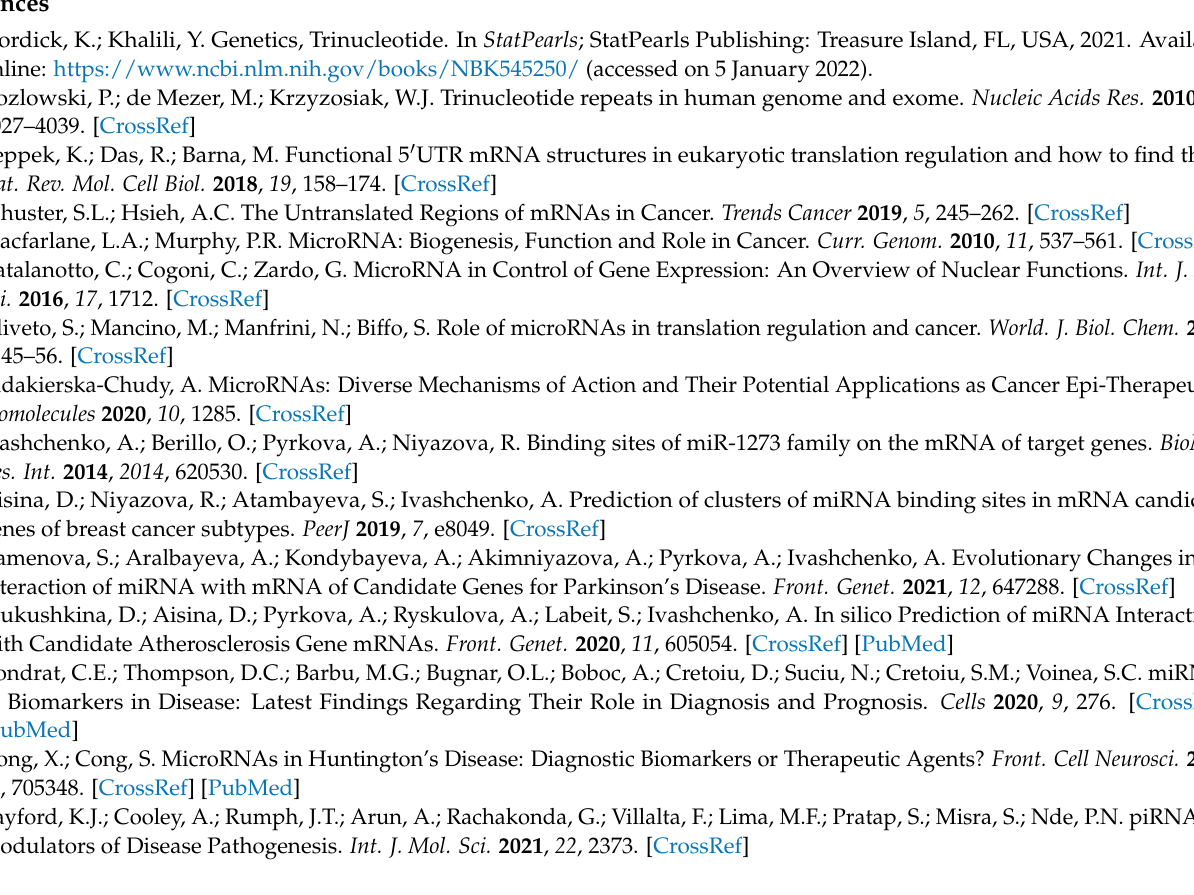
Table S2: Characteristics of miRNAs binding with the 3 (cid:48) UTR mRNAs of genes having GU and AC dinucleotide repeats and associated with oncological diseases. Table S3: Characteristics of miRNAs binding with the 3 (cid:48) UTR mRNAs of genes having GU and AC dinucleotide repeats and associated with diabetes diseases. Table S4: Characteristics of piRNA and miRNA interactions with the 5 (cid:48) UTR mRNAs of genes having trinucleotide repeats and associated with diseases. Table S5: Characteristics of piRNA and miRNA interactions with CDS mRNAs of genes having trinucleotide repeats and associated with